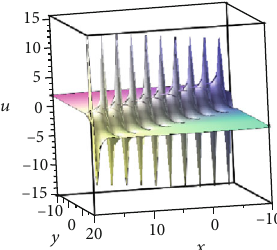
Figure 8: Spatiotemporal structure of solution (28) with the parameter selections a 1 = 1 , a 6 = 1 , a 7 = 1 , k 2 = 1 , δ 1 = 1 , δ 2 = 1 , = 1 , and δ = 1 δ 3 5